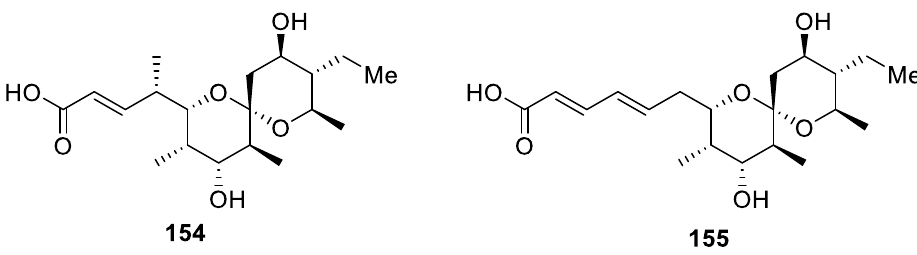
Figure 71. Pteridic acids C and F isolated from Streptomyces sp. SCSGAA 0027 possessing a 1,7-dioxaspiro[5.5.0]undecane motif.